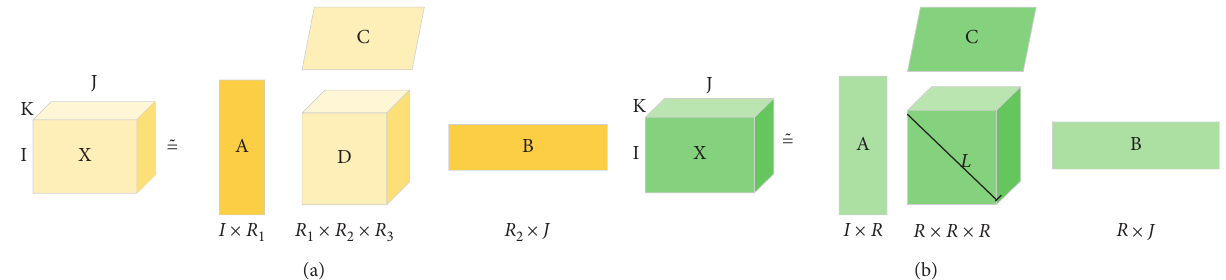
Figure 5: Comparison of PARAFAC decomposition and Tucker decomposition of third-order multidimensional matrix.